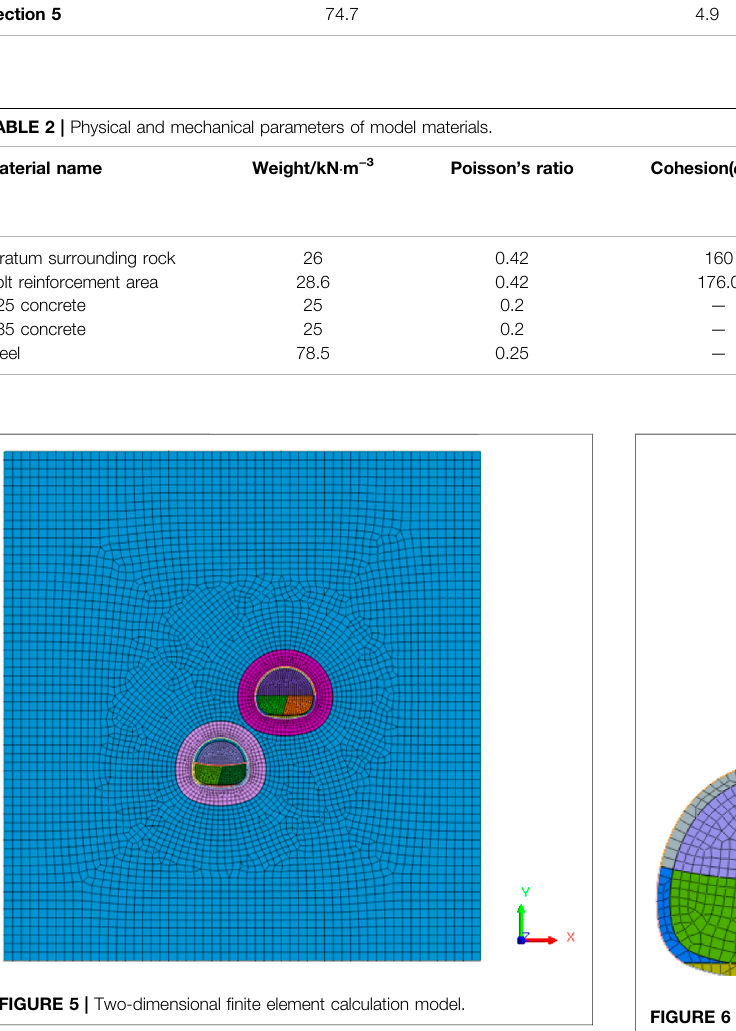
FIGURE 6 | Anchor rod equivalent reinforcement area and secondary lining